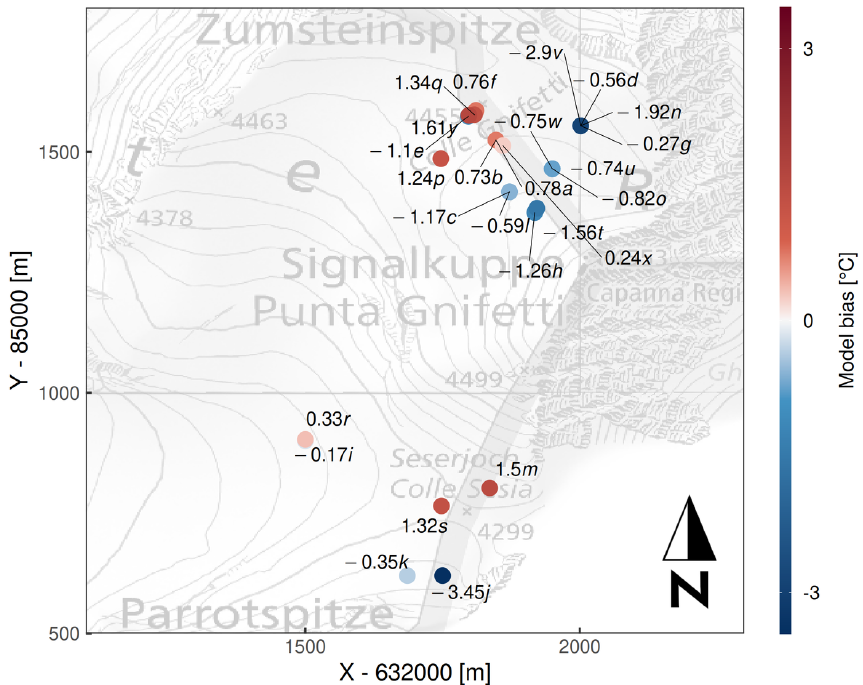
Figure 5. Map of depth-averaged residuals of modeled borehole temperature profiles (20m grid, 1h time step). Letter codes correspond to Fig. 4. x and y are metric CH1903/LV03 coordinates. Topographic map source: Federal Office of Topography swisstopo.